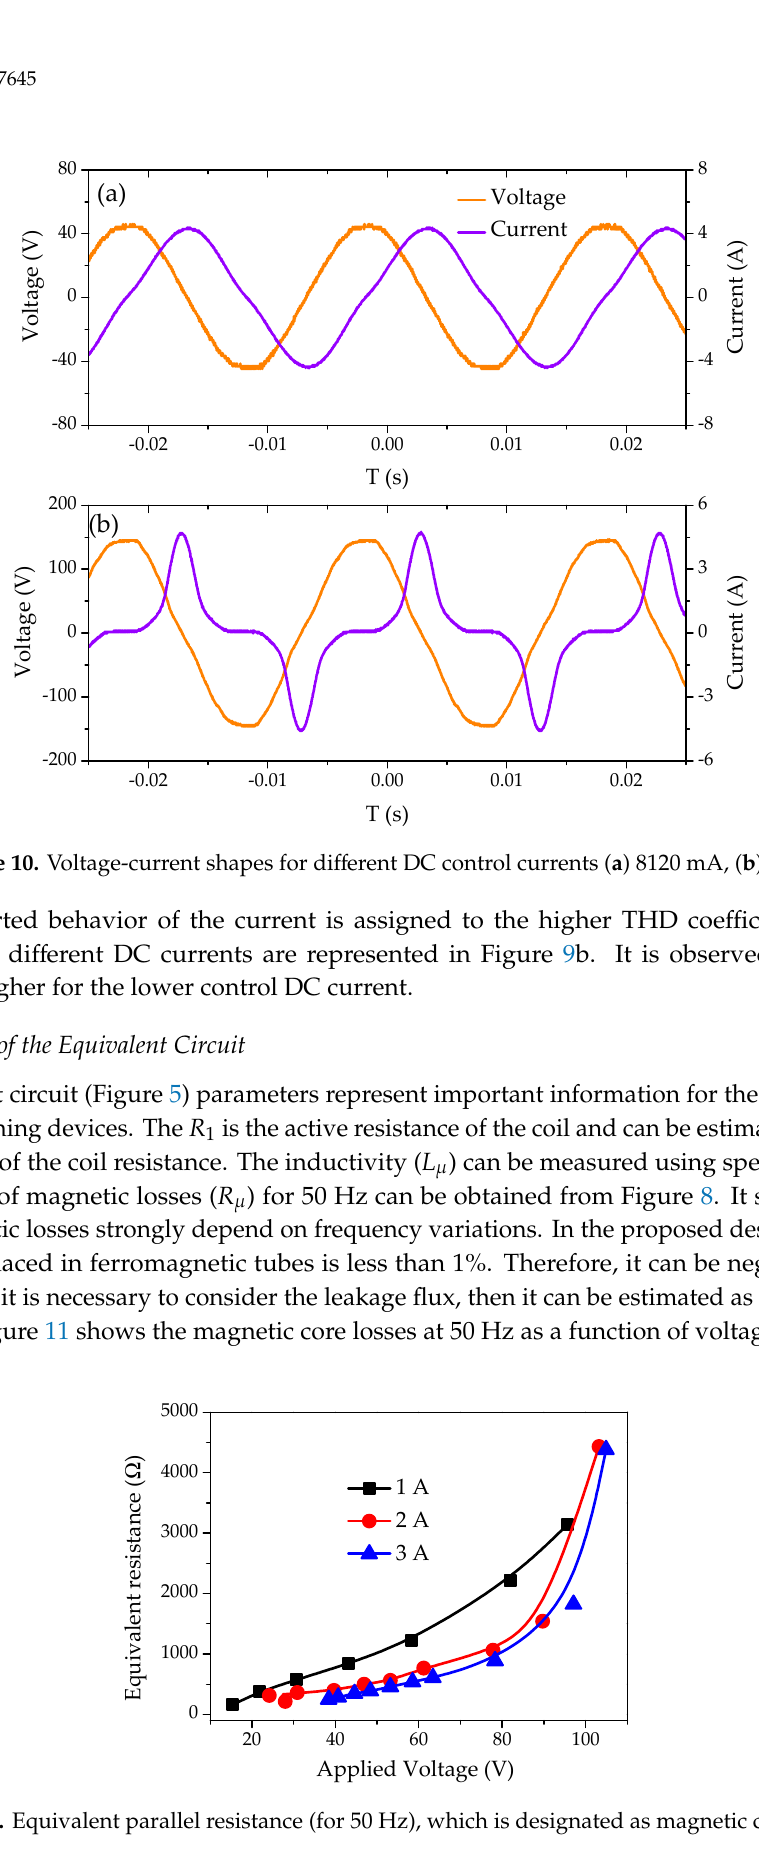
Figure 11. Equivalent parallel resistance (for 50 Hz), which is designated as magnetic core losses.